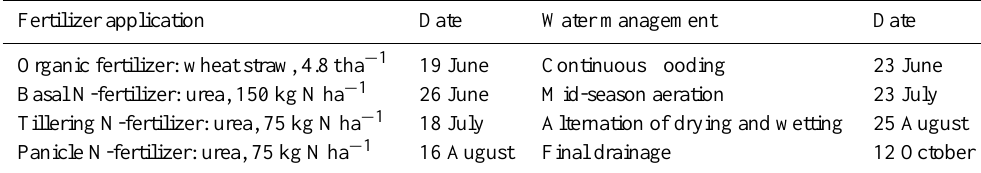
Table 1. Schedule of fertilizer application and water management during the rice season. Fertilizer